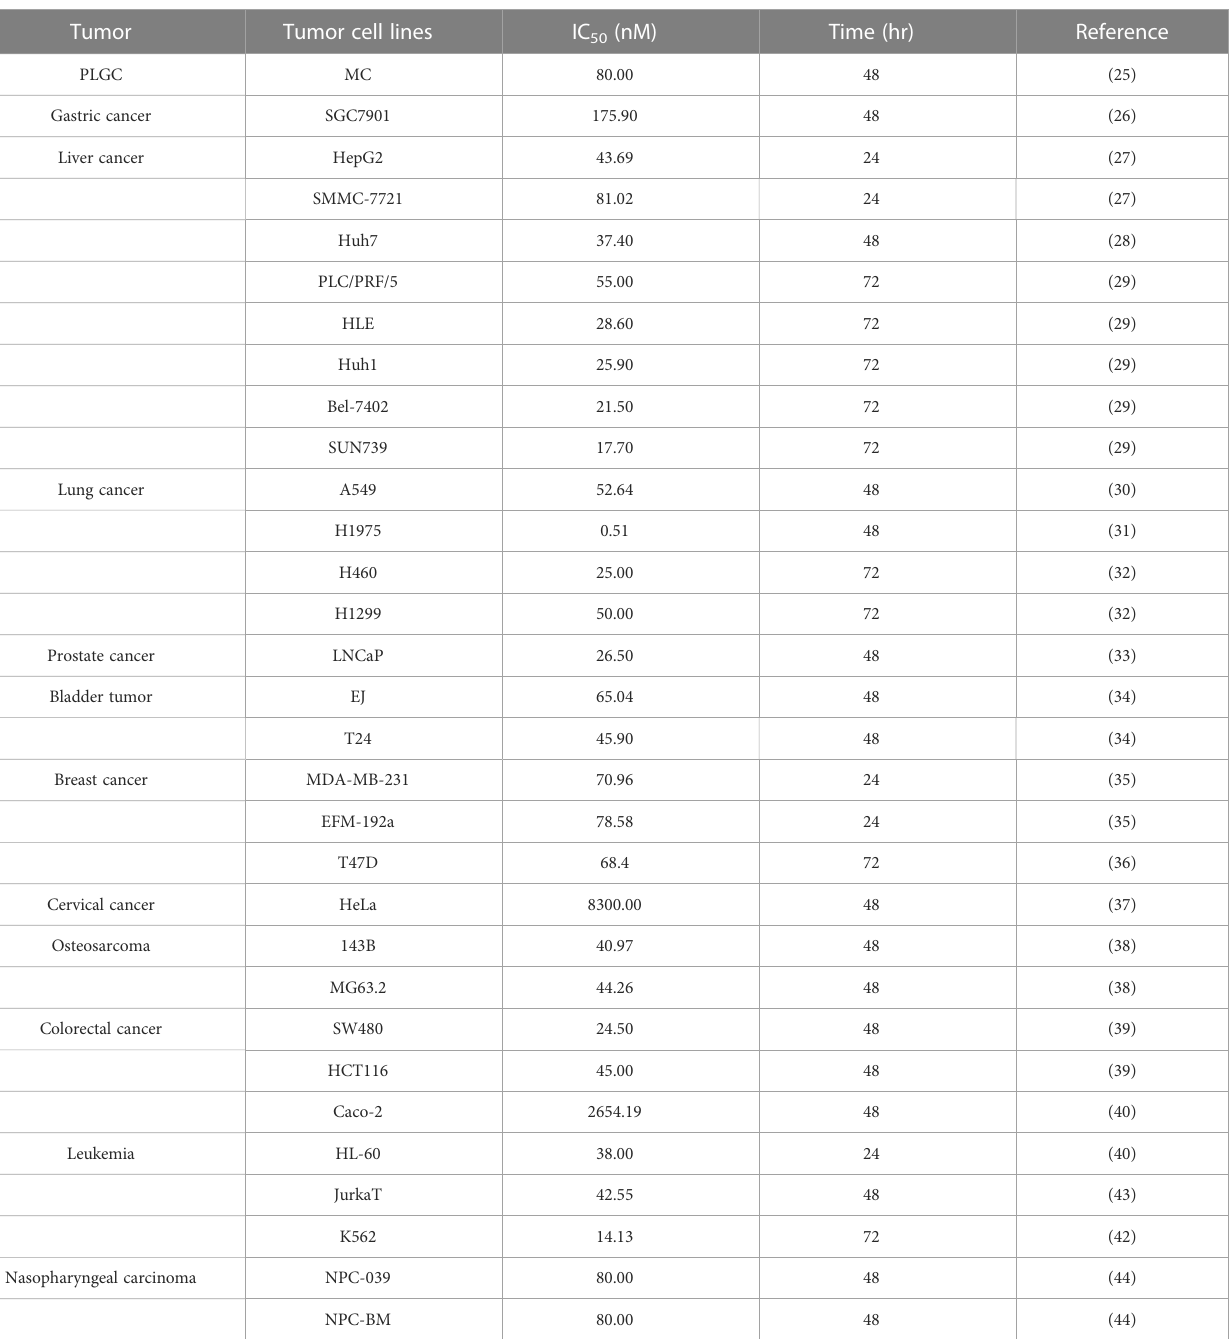
TABLE 1 Inhibitory effect of ERIANIN on different tumor cell lines. Tumor Tumor cell lines IC